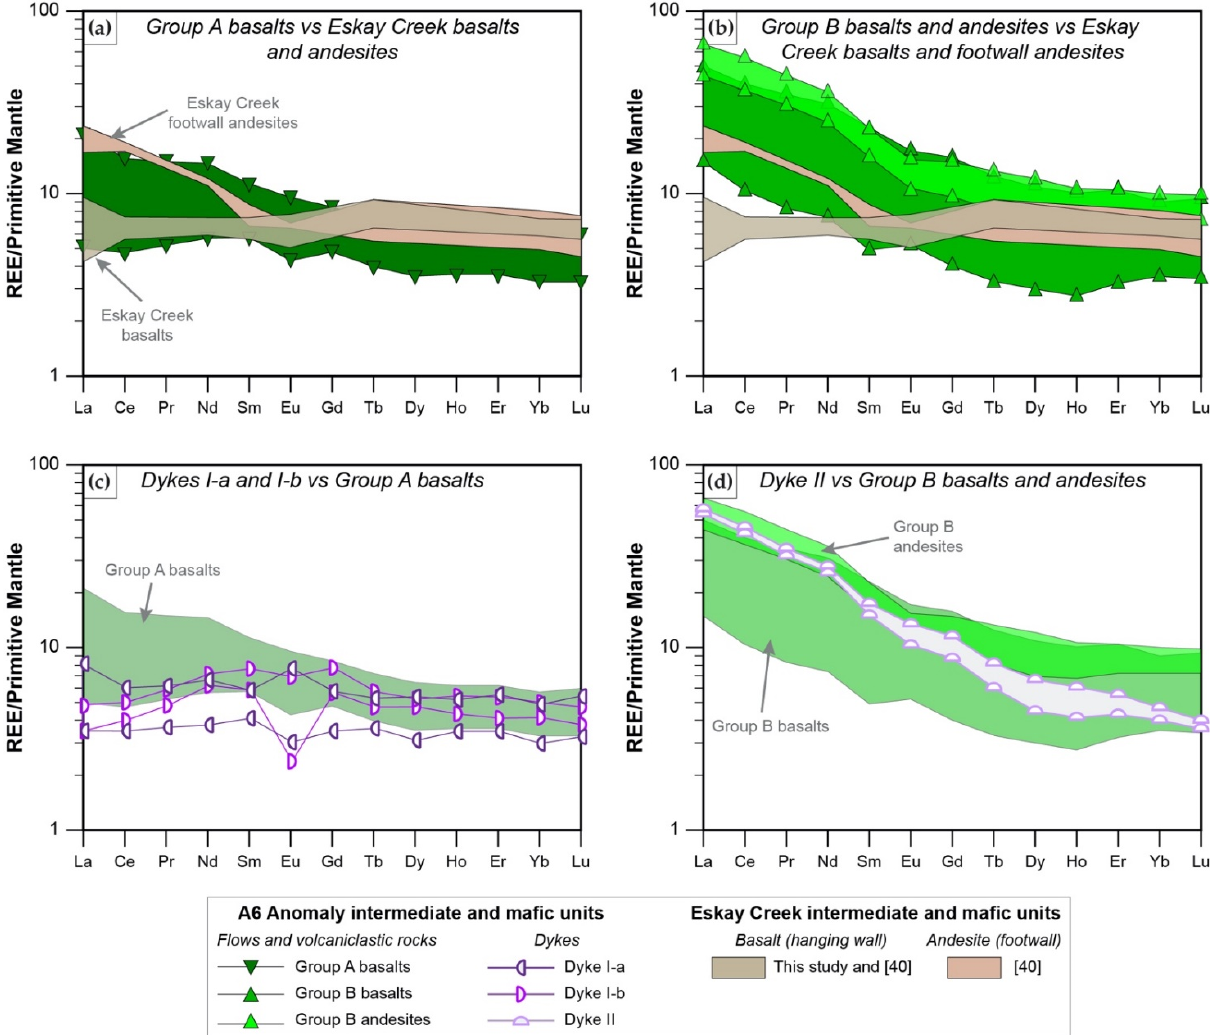
Figure 12. Spider diagrams of REEs normalized to primitive mantle [58] for the different mafic and intermediate units at the A6 Anomaly, ( a ) Group A basalts in comparison to Eskay Creek basalts and andesites, ( b ) Group B basalts and andesites in comparison to Eskay Creek basalts and andesites, ( c ) dykes I-a and I-b dolerites in comparison to Group A basalts, ( d ) dyke II dolerite in comparison to Group B basalts and andesites. Note: REE patterns for Group 1 and Group 2 basalts [10] overlap with Group A basalts and are not shown here since emphasis is on lithologies of the A6 Anomaly.